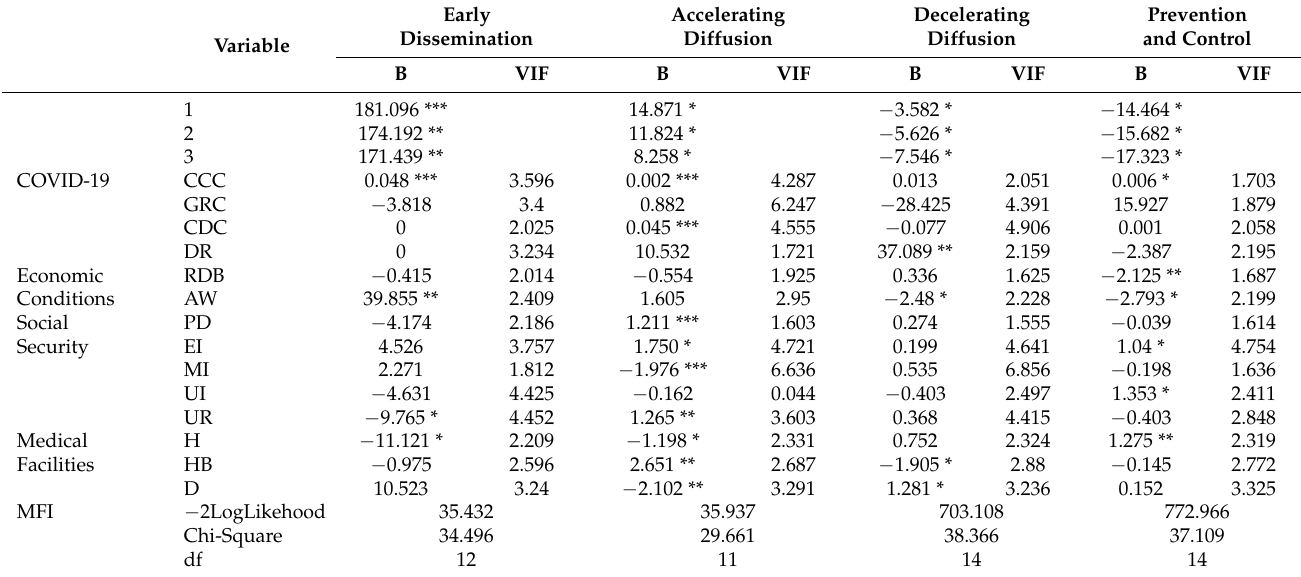
Table 2. Influencing factors of the environmental risk perception of each city during COVID-19 epidemic.